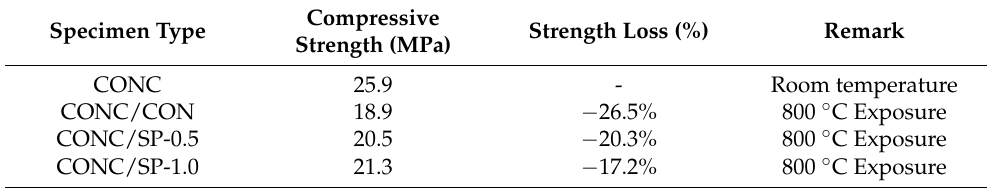
Table 7. Compressive strength of plastered samples after heat